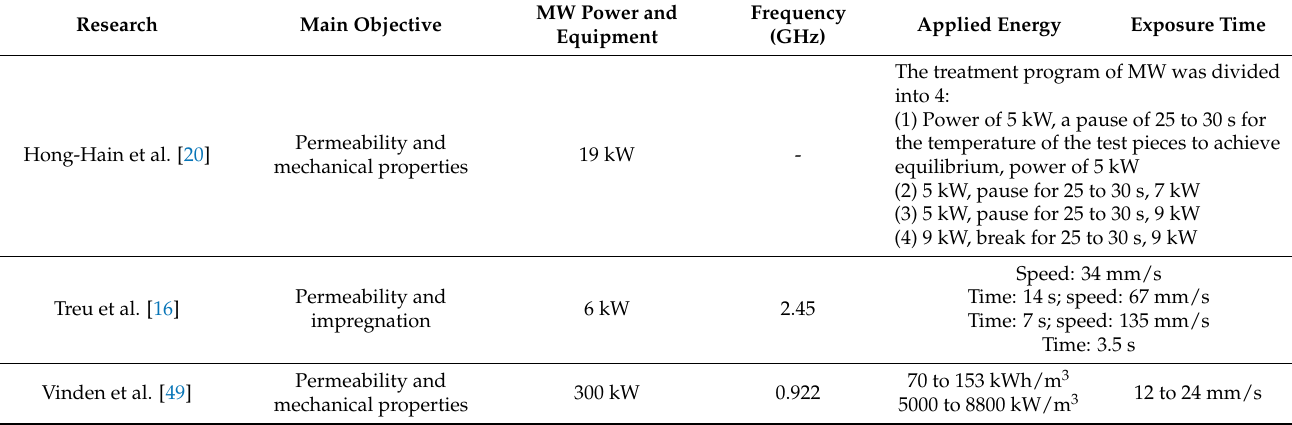
Table 15. Summary of key information of the research papers using MW technology for permeability.